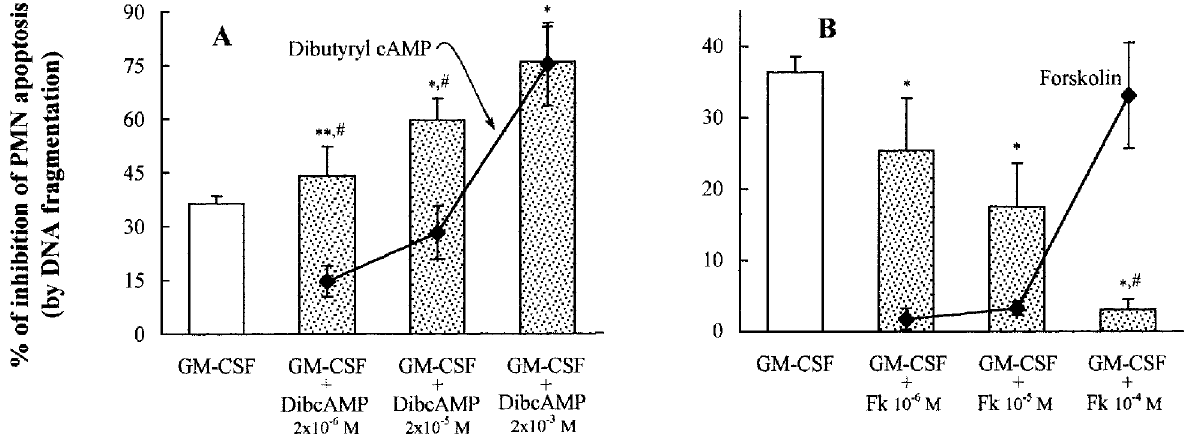
FIG. 1. Effects of GM-CSF and cAMP-elevating agent interaction on spontaneous neutrophil apoptosis. Neutrophils were cultured in vitro for 24h in the absence or presence of GM-CSF (1000UI/ml; white columns), dibutyryl cAMP (panel A) and forskolin (panel B) (both represented with a solid line), or a combination of GM-CSF and either of cAMP-elevating agents (dotted columns). Cells were then recovered and further processed for the analysis of DNA fragmentation. Results are expressed as percentage of inhibition (mean±SD) of low to high molecular weight DNA ratio in treated compared to untreated cell cultures, and are obtained from 12 independent donors. Significance versus cell suspensions treated with GM-CSF only: ** p <0.01 and * p <0.001; significance versus PMN treated with homologous concentrations of dibutyryl cAMP or forskolin: # p